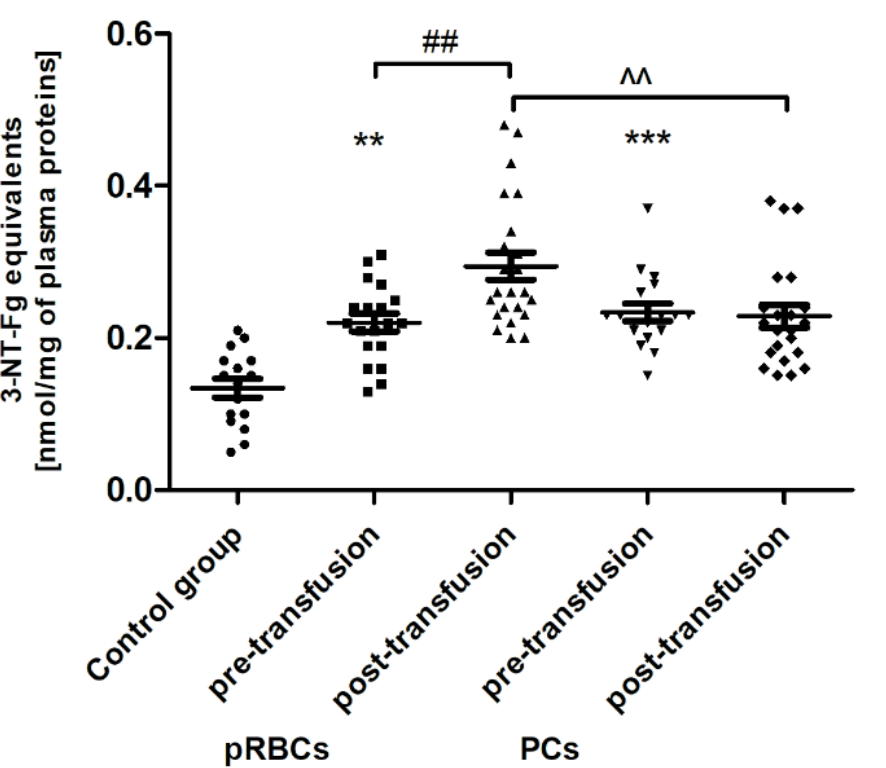
Figure 3. The level of 3-NT in plasma proteins in healthy volunteers (control group) and AML patients before and after transfusion of the blood component. Scatter plots show all of the data values obtained. Data are presented as mean ± SE. ** p < 0.01, *** p < 0.001 compared to the control group; ## p < 0.01 compared post- versus pre-transfusion; ˆˆ p < 0.01 compared post-transfusion pRBCs versus PCs; statistically significant according to the Tukey test. pRBCs—packed red blood cells; PCs—platelet concentrates.